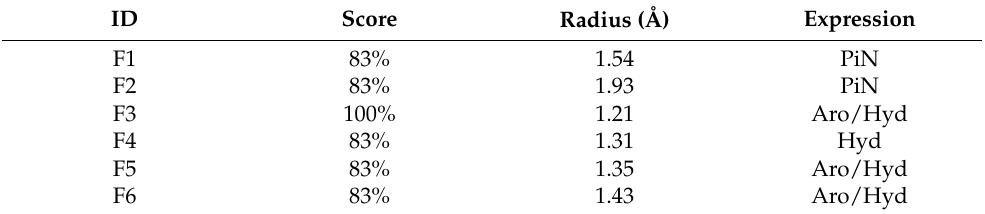
Table 2. List of pharmacophore features shared by 80% of the potentiators herein studied, along with their ID, score, radius, and expression parameters.